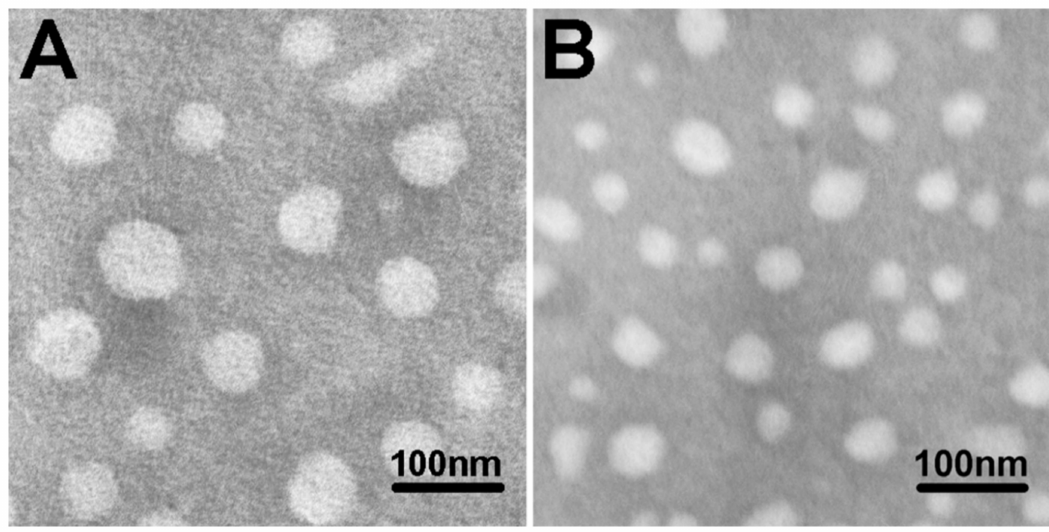
Figure 3. TEM images of LysP / DNA ( A ) and HisP / DNA ( B ) complexes at their optimal transfection w / w ( LysP : w / w = 4; HisP : w / w = 14) in deionized